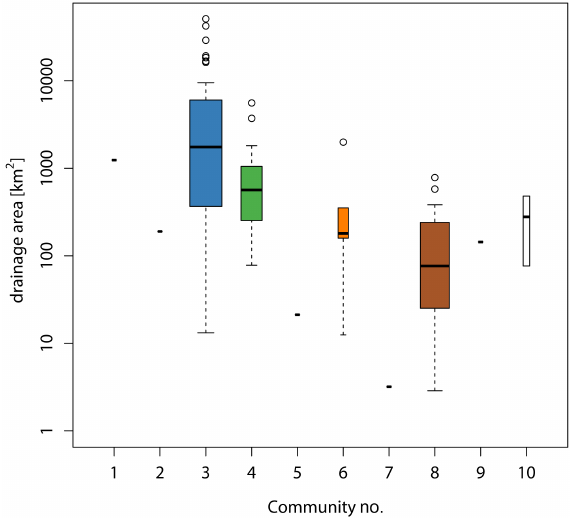
Figure 11. Boxplots of upstream basin drainage area grouped by community. The colours are consistent with the map in Fig.